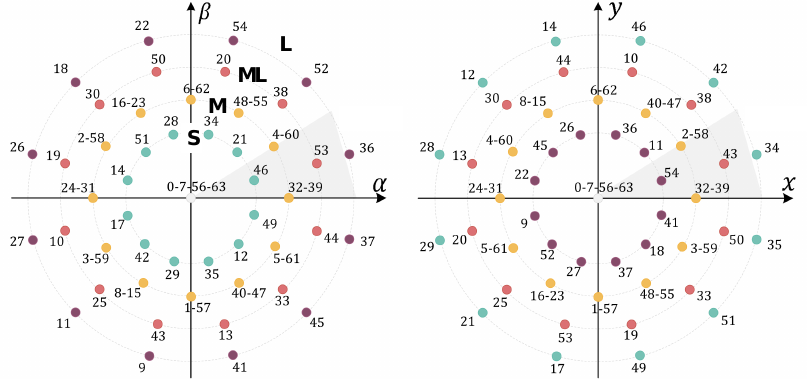
Figure 2. Voltage vectors, numbered from 0 to 63, for a six-phase VSI shown in α − β plane ( left ) and x − y plane ( right ). The S, M, ML and L coronas have been highlighted in the α − β